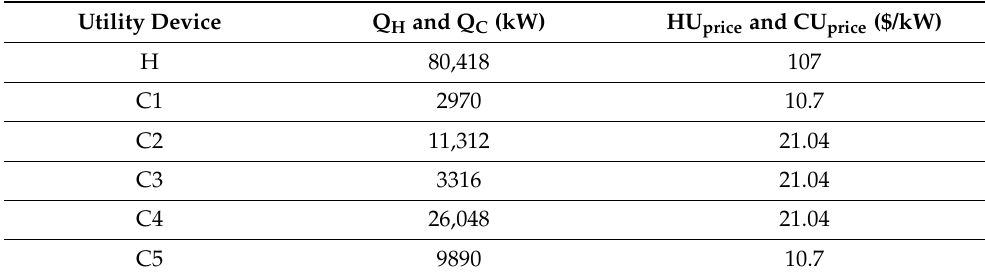
Table 2. Existing HEN utility